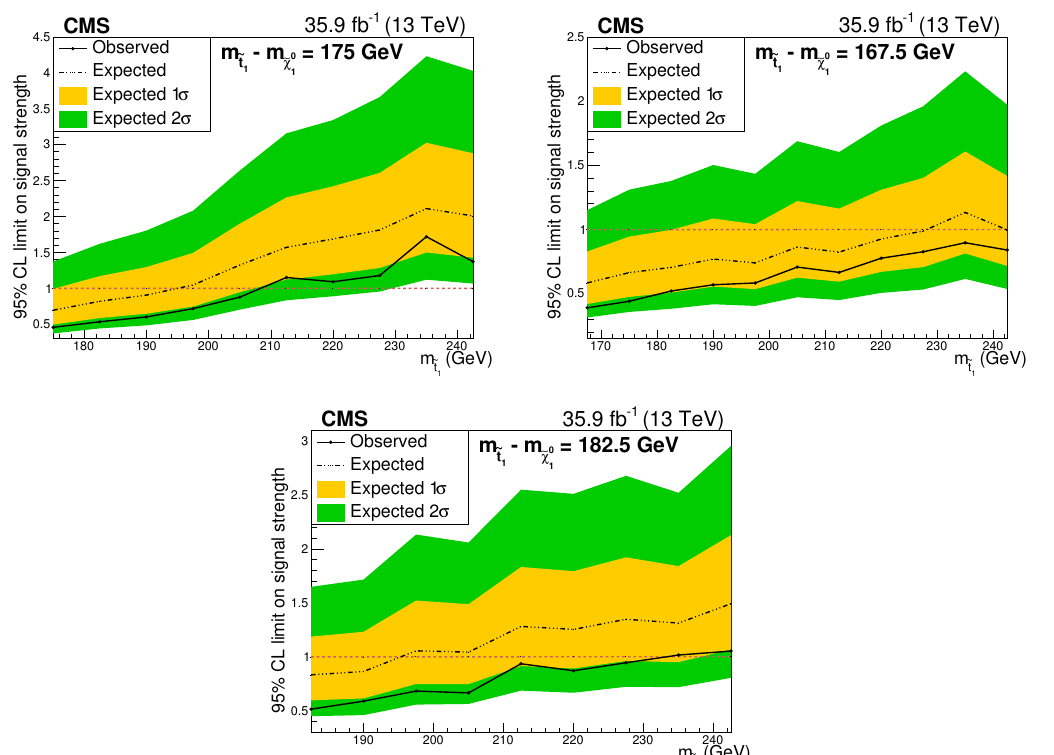
Figure 5 . Expected and observed upper limits at 95% CL on the signal strength as a function of (cid:0) m the top squark mass for m = 175 GeV (upper left), m e t 1 e (cid:31) 0 1 (cid:0) m and m = 182 : 5 GeV (lower). The green dark and yellow light bands correspond to the 68 e t 1 e (cid:31) 0 1 and 95% CL ranges of the expected upper